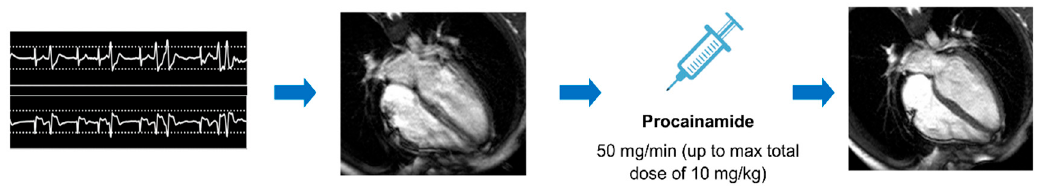
Figure 1. Study protocol. In patients presenting for the Cardiac Magnetic Resonance study with frequent ventricular ectopics and significantly impaired image quality, procainamide was administered on the scanner bed at intermittent intravenous bolus doses. The result was the successful suppression of premature ventricular contractions in most of the patients and a high image quality.